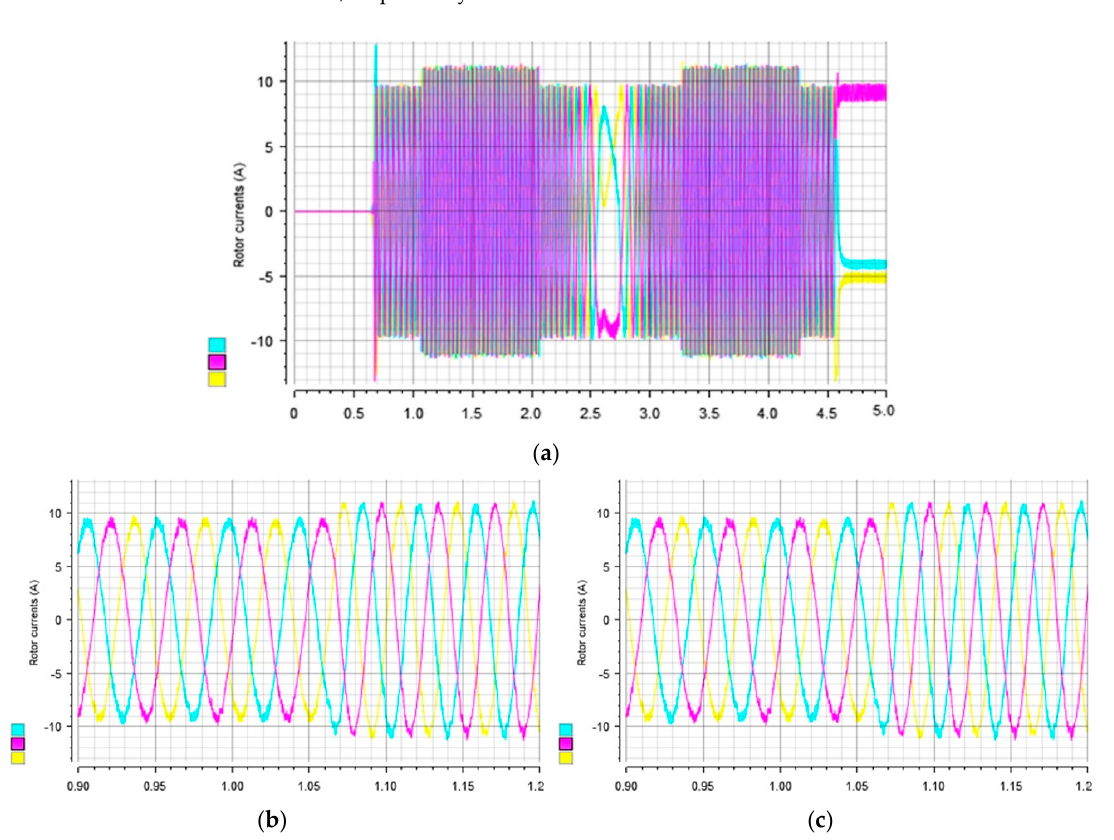
Figure 22. ( a ) Stator currents of the GA–DTC; ( b , c ) zooms of currents from 0.9 s to 1.2 s, and from 1.9 s to 2.2 s, respectively.